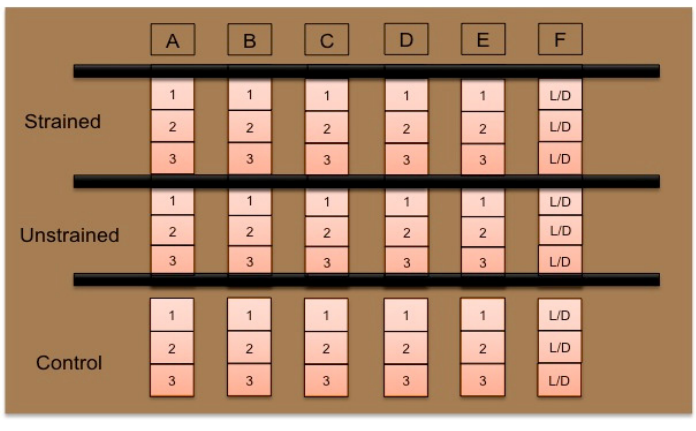
Figure 4. Relative position of each section of scaffold for assays. Positions 1, 2, and 3 refer to position on the scaffold and proximity to clamps. L/D refers to sections of the scaffolds designated for Live/Dead